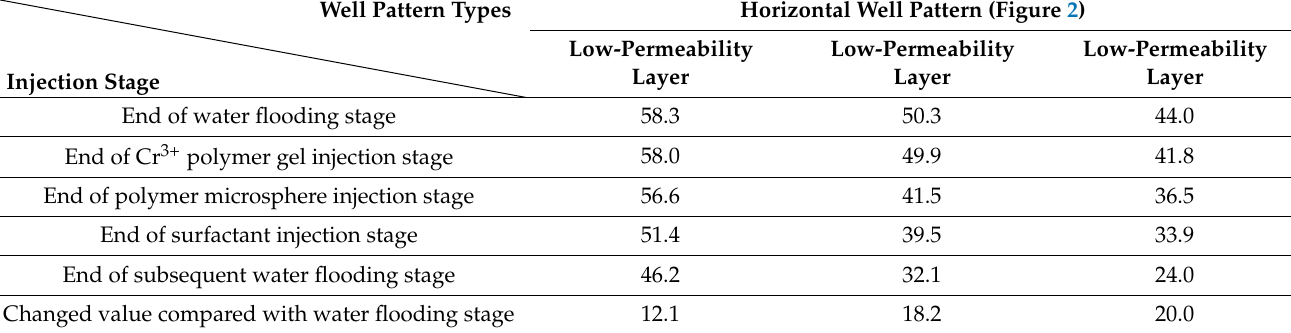
Figure 12. Remaining oil distribution of each layer after subsequent water flooding stage of Figure 2: ( a ) low-permeability layer, ( b ) medium-permeability layer, ( c ) high-permeability layer. Table 7. The remaining oil saturation (%) results of Figure 2 .